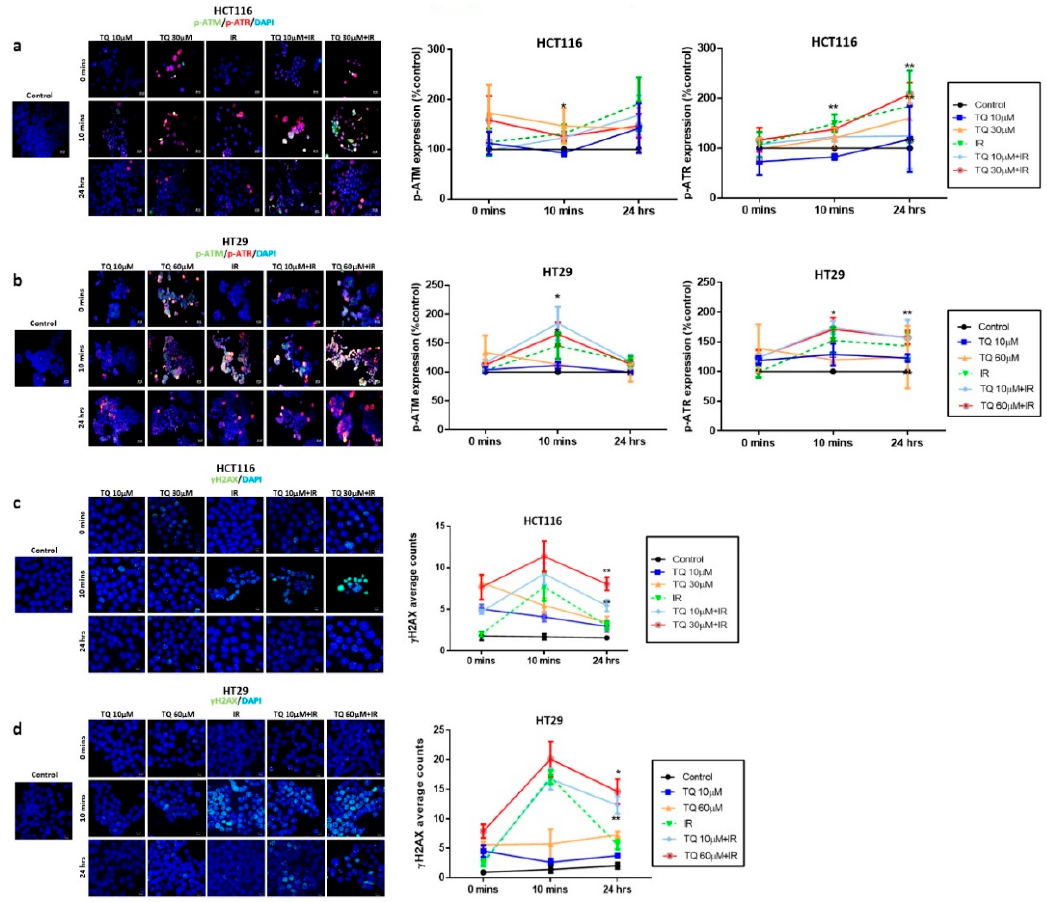
Figure 2. TQ radiosensitization of colorectal cancer cells is associated with DNA repair inhibition. HCT116 and HT29 cells were either left untreated or incubated with TQ for 24 h followed by irradiation at 2 Gy. Cells were then fixed at 0 min, 10 min and 24 h post irradiation, followed by permeabilization and staining for p-ATR, p-ATM ( a , b ), and Gamma H2AX ( γ H2AX) ( c , d ). Quantification and representative images are shown. Quantification of p-ATM and p-ATR intensity was performed using Carl Zeiss Zen 2012 image software. γ H2AX foci were counted using the confocal microscope. Data represent an average of three independent experiments and are reported as mean ± SEM (* p < 0.05; ** p < 0.01 significantly different from control for p-ATM and p-ATR, and from IR for γ H2AX). Scale bar for immunofluorescent images is 20 µ